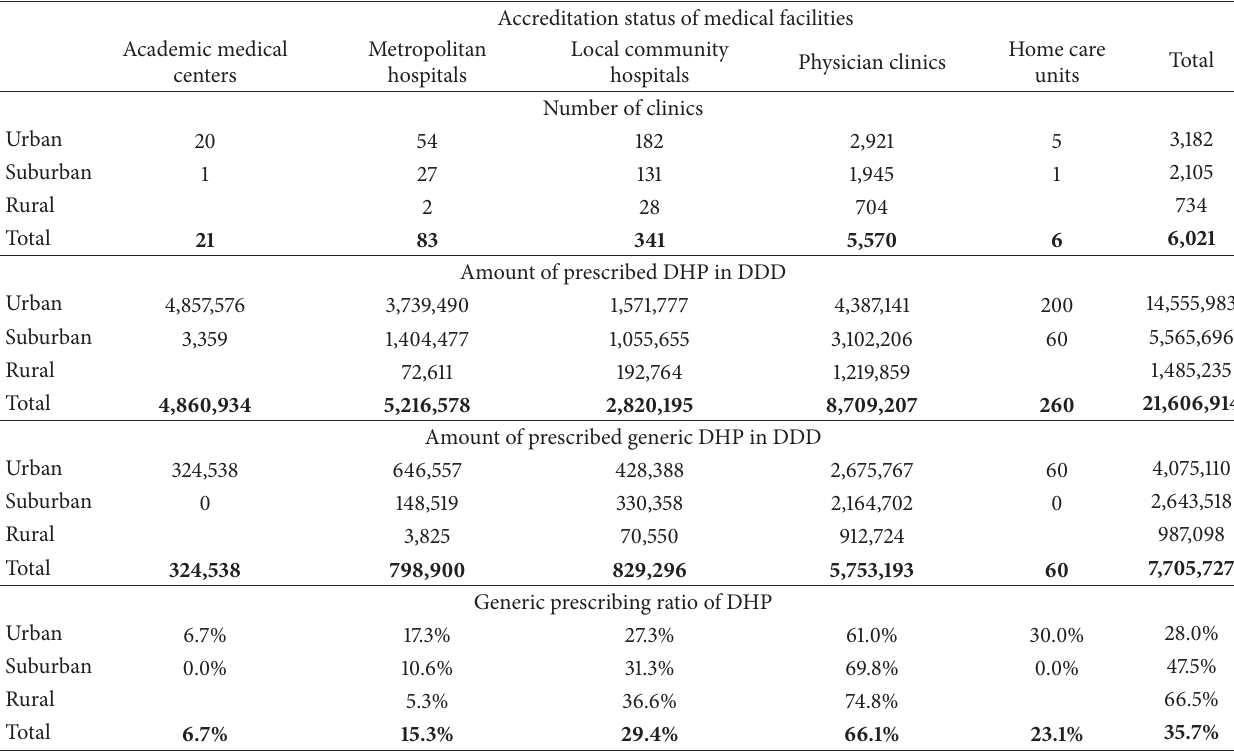
Table 2: Aggregate prescribing amount of DHP derivatives in one million beneficiaries within Taiwan’s National Health Insurance in 2010, stratified by accreditation status and urbanization level.